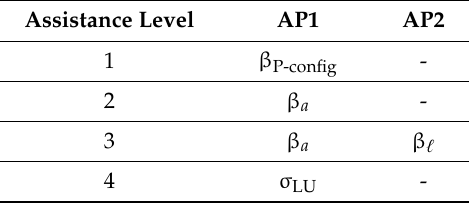
Figure 2. The ANN structure: ( a ) traditional direct independent inputs approach, ( b ) assisted approach with calculated assistance parameters. Table 1. The ANN assistance input parameters for the di ff erent levels of